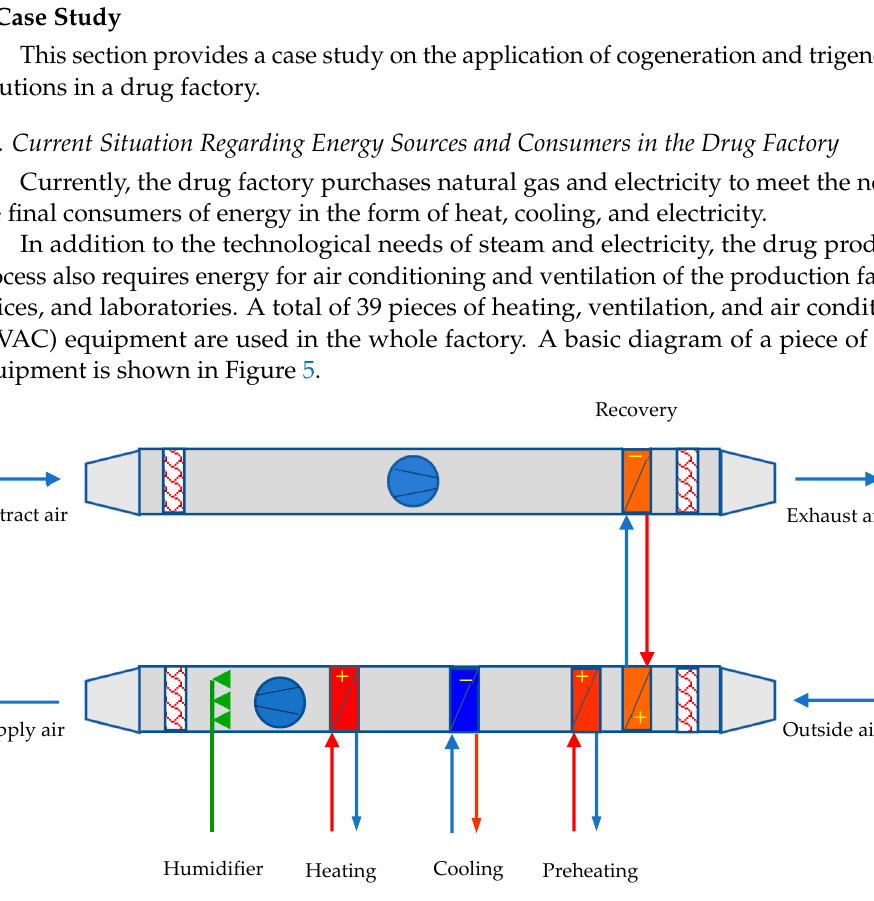
Figure 5. Diagram of heating, ventilation, and air conditioning (HVAC) equipment.